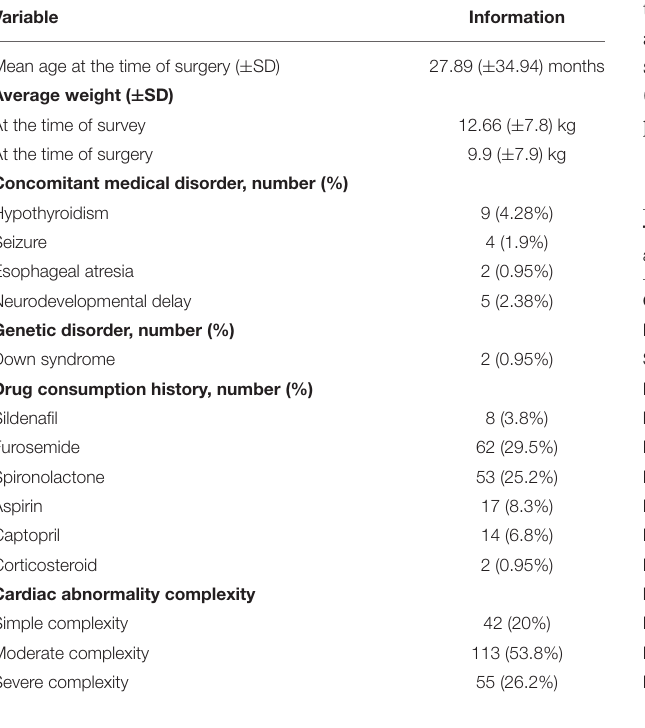
TABLE 1 | Demographic data and the complexity of underlying cardiac disease among 210 patients.